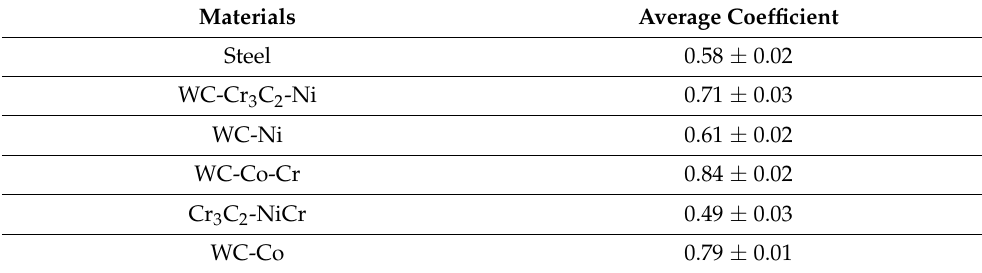
Figure 8. WC-Cr 3 C 2 -Ni, WC-Ni, WC-Co-Cr, Cr 3 C 2 -NiCr and WC-Co. Table 4. Friction coefficient values and their standard